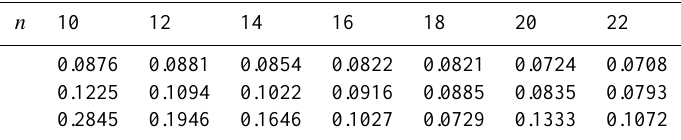
Table 10. Average divergence and the relative error for E( 1 . 5 ) .